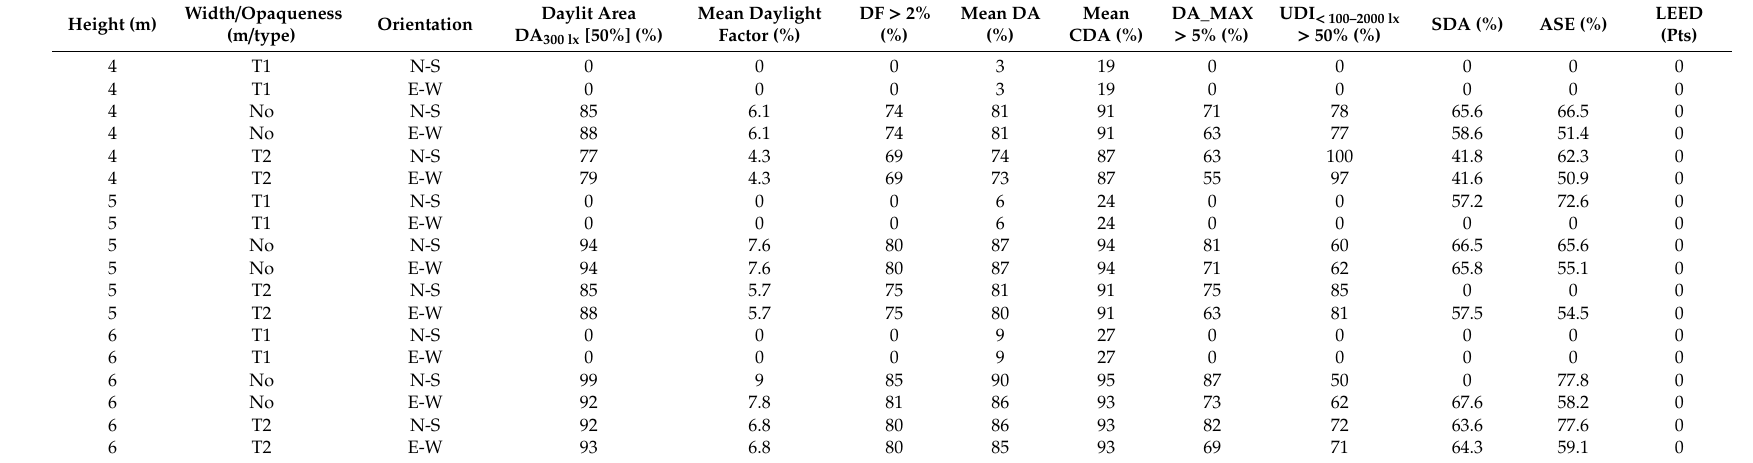
Table 6. Daylight Simulation Results for skylight